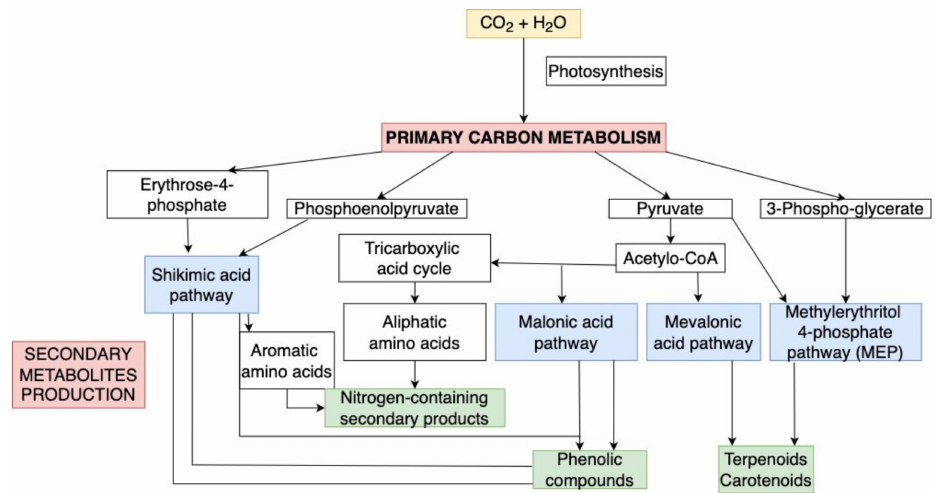
Figure 1. Main pathways for the synthesis of secondary metabolites in trees